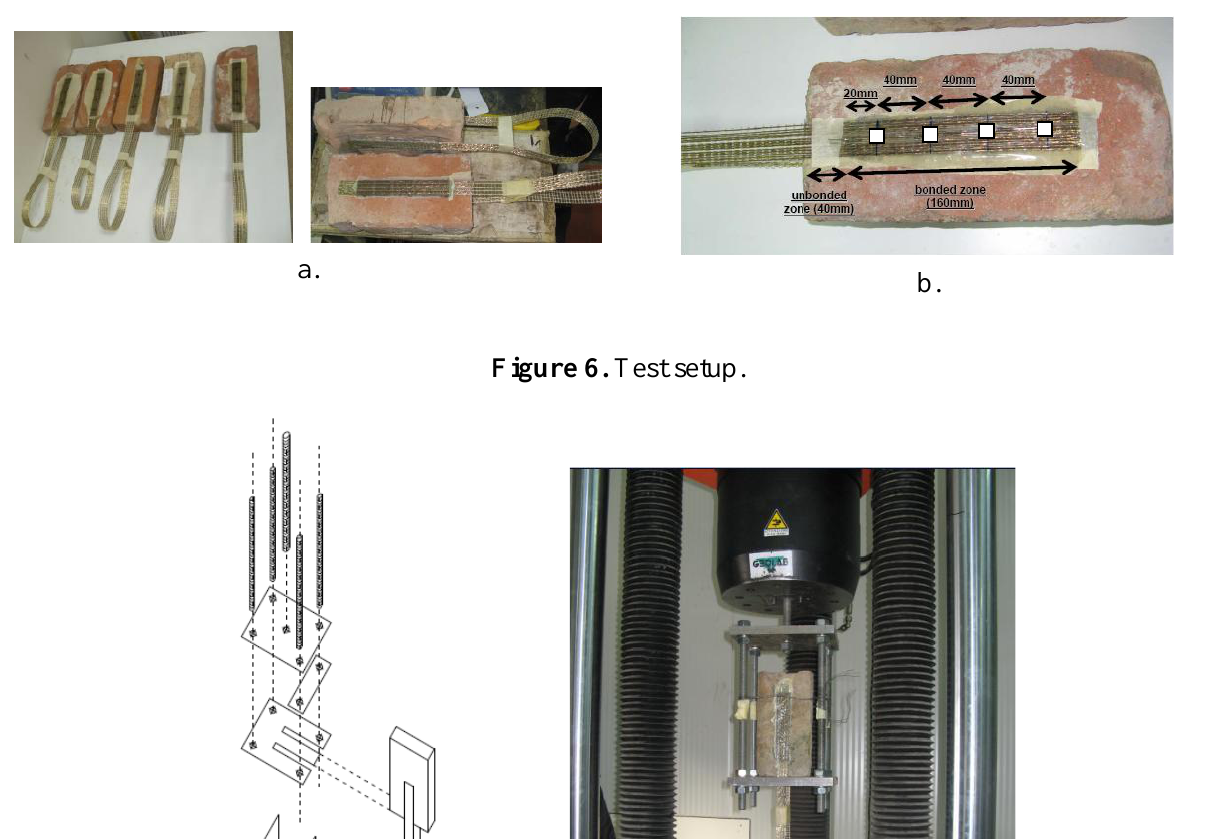
Figure 5. ( a ) Specimens’ configuration; ( b) Strain gauges